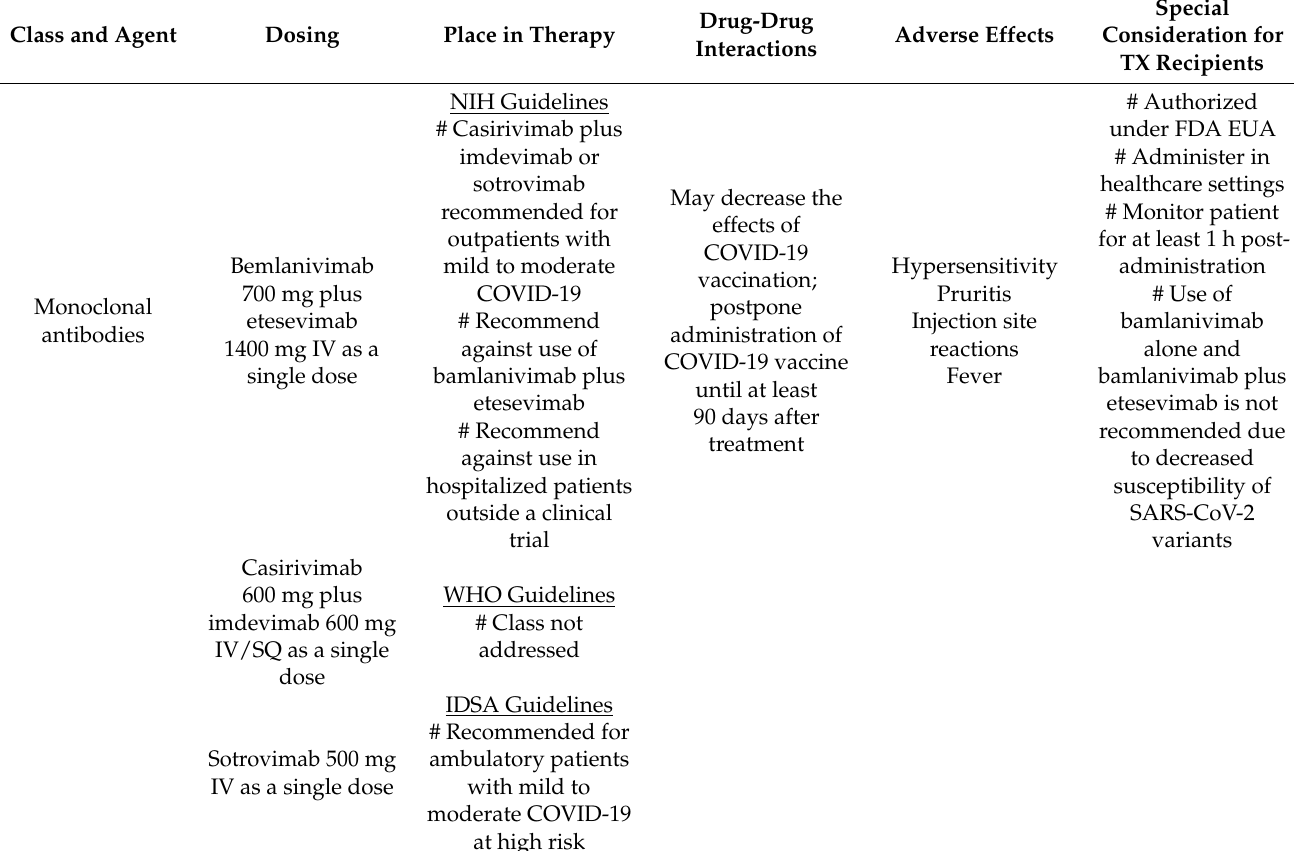
Table 6. Characteristics of monoclonal antibodies for the treatment of COVID-19.